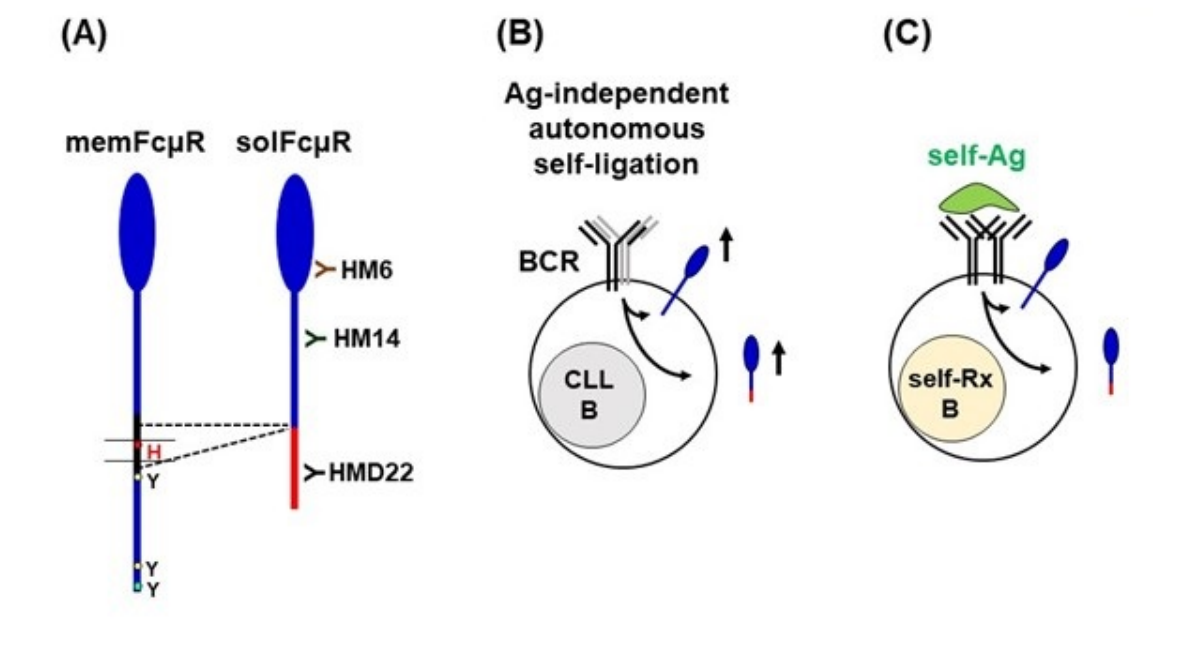
Figure 7. Enhanced expression of both membrane-bound and soluble isoforms of Fc µ R in patients with CLL and possible autoimmune diseases. ( A ) The novel 70-aa C-terminal hydrophilic tail of soluble Fc µ R (solFc µ R), which results from alternative splicing of membrane Fc µ R (memFc µ R) with skipping of the transmembrane exon, is highlighted in red. Three representative mAbs reactive with different epitopes on the solFc µ R are shown. ( B ) Antigen-independent, autonomous self-ligation of BCR is the hallmark of the neoplastic CLL B cells. This may account for the enhanced expression of both memFc µ R and solFc µ R. ( C ) The hypothesis here is that persistent BCR stimulation with self- antigens, such as in antibody-mediated autoimmune diseases, results in increases of both memFc µ R and solFc µ